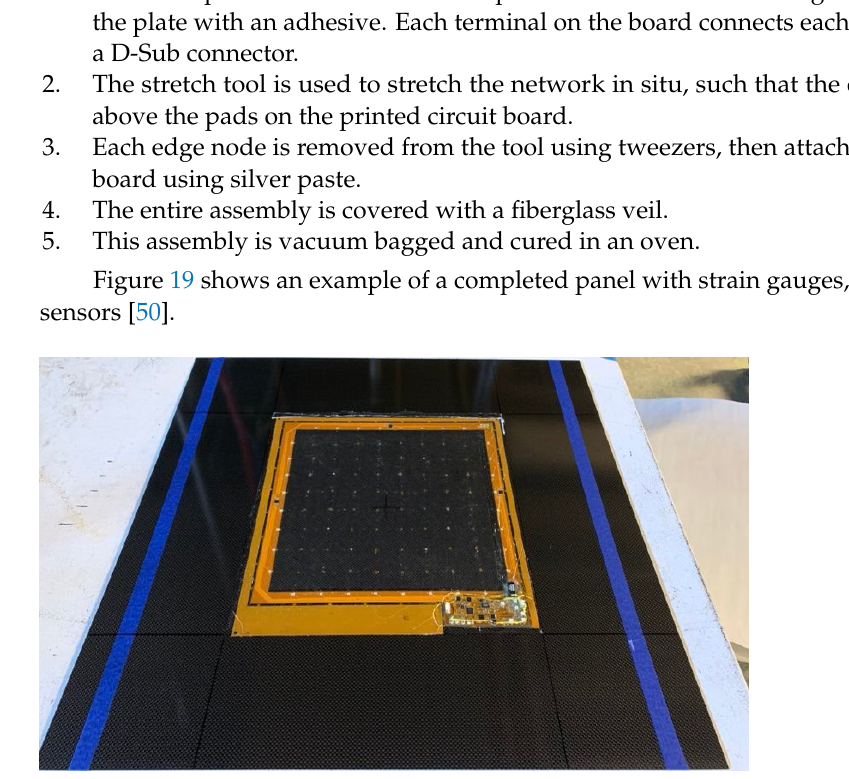
Figure 19. An SSN integrated with a composite